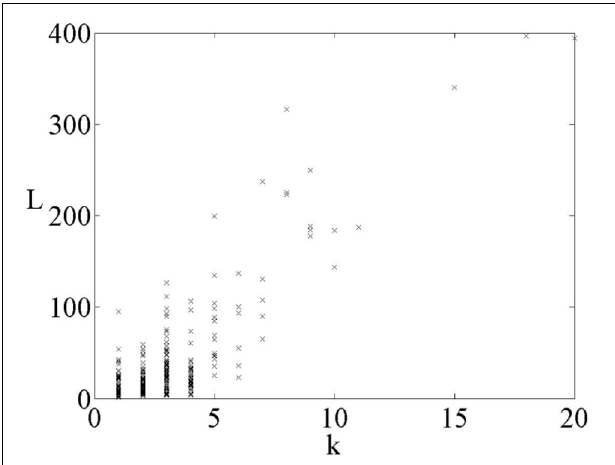
FIGURE 7 | Fracture length l , plotted as a function of node degree, k , for a sample network made from a SAR image.